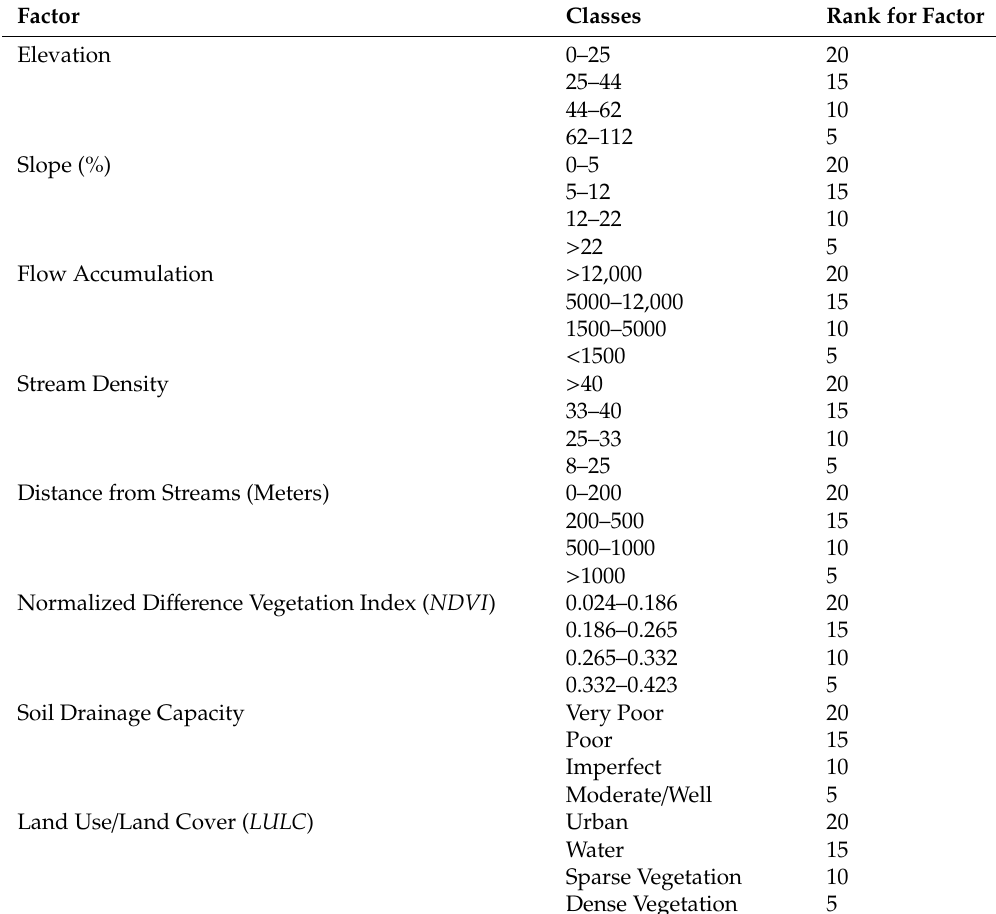
Table 1. Classes of each factor and corresponding rank